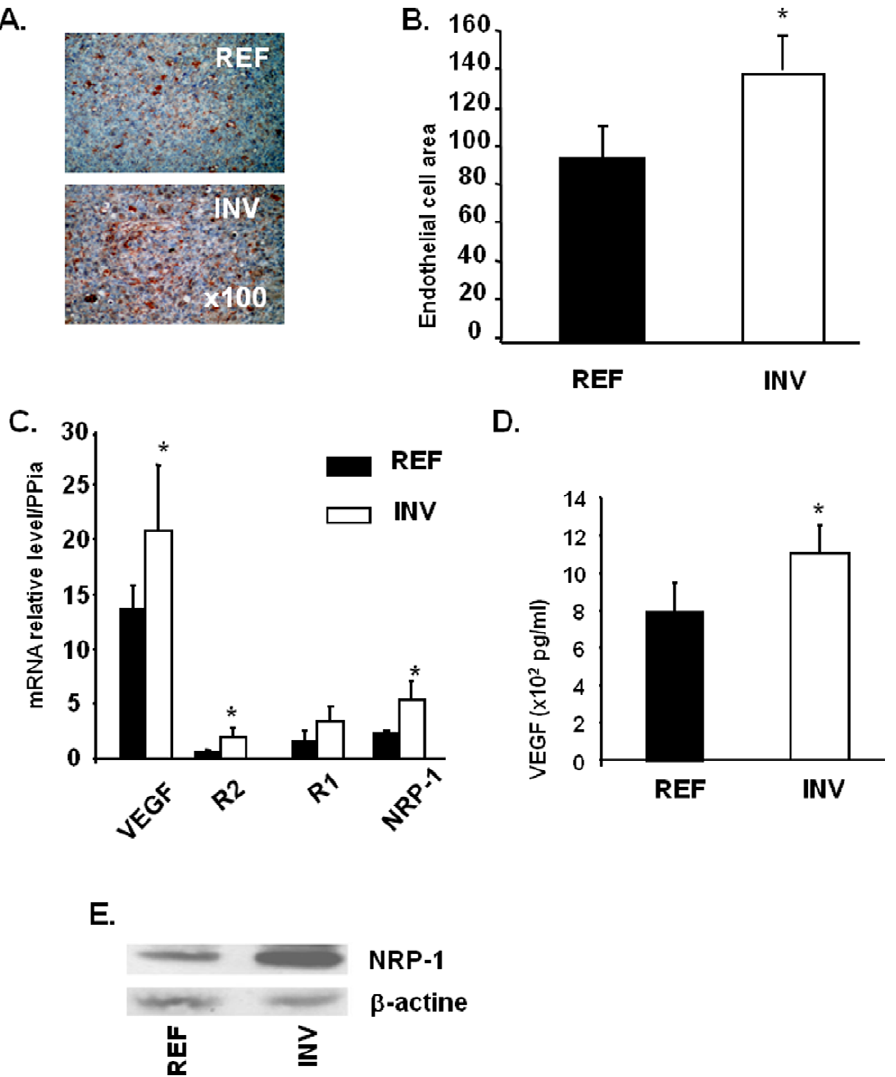
Figure 6. REF and INV tumor angiogenesis. Endothelial cells in REF and INV tumor sections were stained as described in ‘‘Materials and Methods’’. Microvessels are revealed by brown staining (magnification 6 100) and endothelial cells were quantified (B). QRT-PCR was used to quantify VEGF , VEGFR2 , VEGFR1 and NRP-1 gene expression in INV and REF cells (C). VEGF (D) and NRP-1 (E) proteins were detected by ELISA tests and by western blotting, respectively. Each column represents a mean ( 6 SD) of three independent experiments. * P , 0.05. Gene functions from the GO Description provided by NetAffx TM Analysis Center Affymetrix (https://www.affymetrix.com/analysis/netaffx/index.affx)* Validated by QRT-PCR.